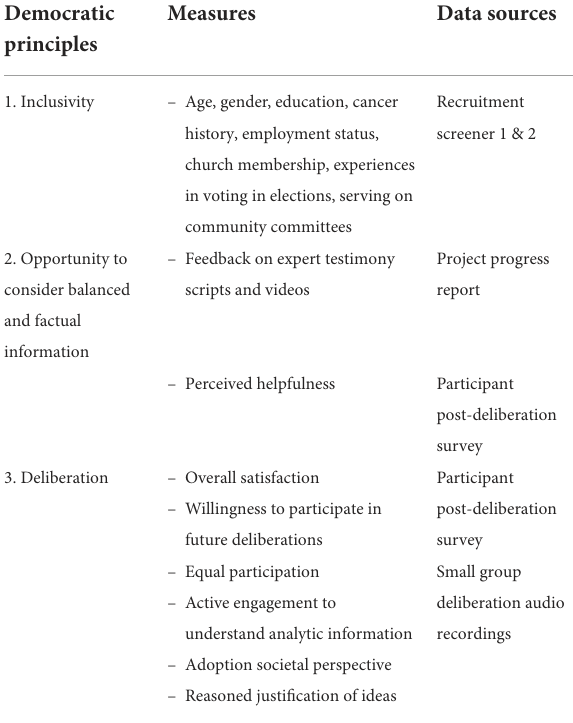
TABLE 1 Deliberation evaluation measures and data